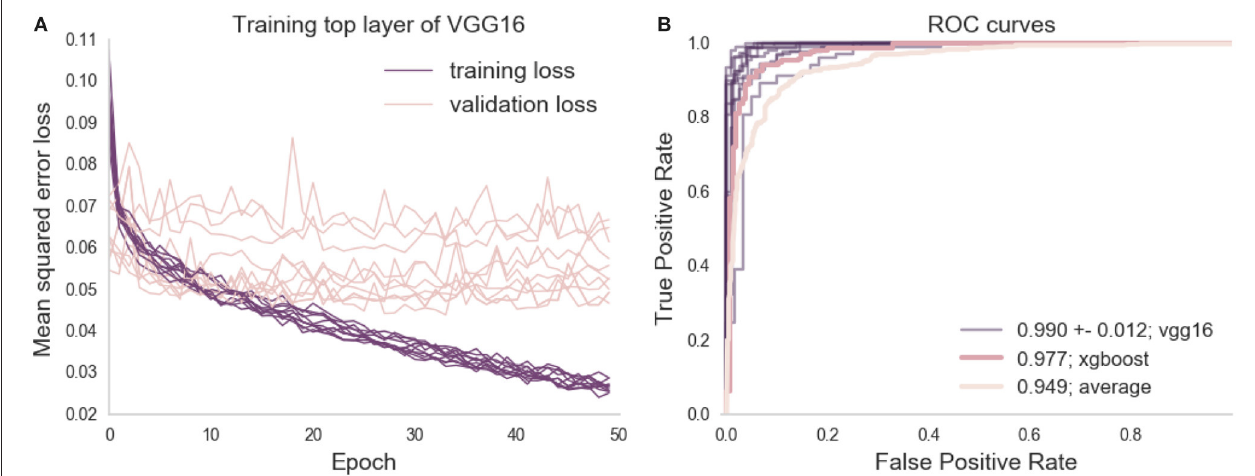
FIGURE 3 | Deep learning training and evaluation on the left out test set. (A) Shows the training and validation loss scores for 10 training runs, each with a different initialization seed. The training loss tends toward 0 but the validation loss plateaus between 0.05 and 0.07 mean squared error at the 10th epoch. (B) Shows the ROC curve of the prediction on the test set against the binary classified gold-standard slices, along with the ROC curves computed from previous analysis (the average citizen scientist rating, and the XGBoosted